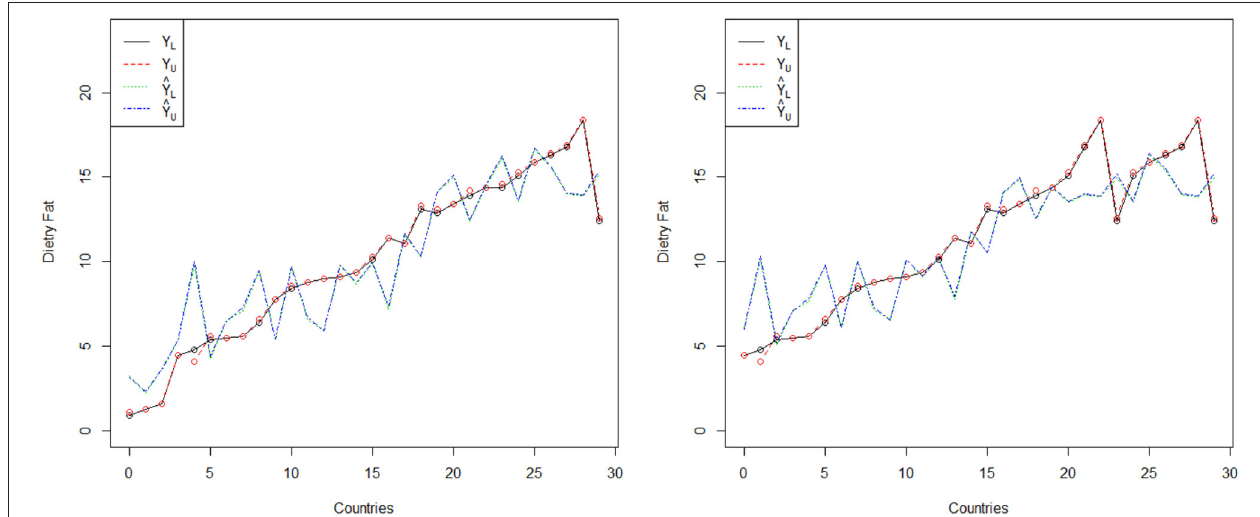
FIGURE 1 | The trended lines of two regression